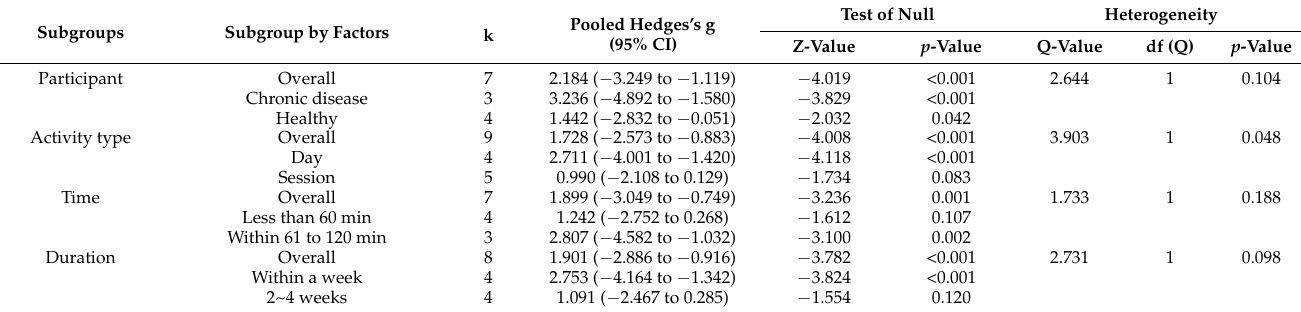
Table 4. Modulator effect analyses for the effects of forest therapy on anxiety.